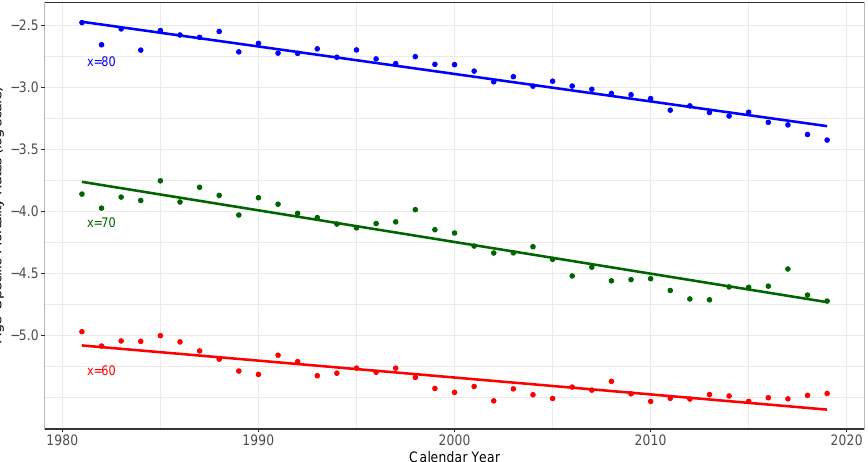
Figure 3. Observed log m ( t , x ) values of females in Greece, for ages 60, 70, 80, over the period 1981–2019. The straight lines denote the trend in mortality